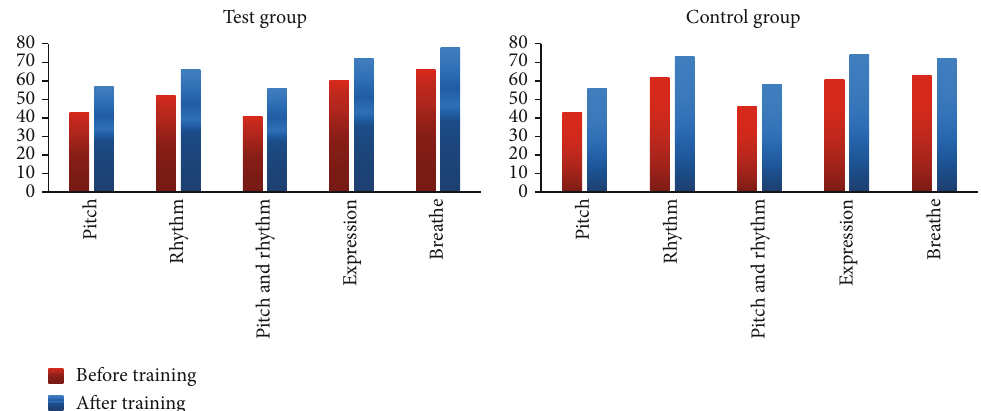
Figure 9: Comparison of the results of the experimental group and the control group before and after the experiment.